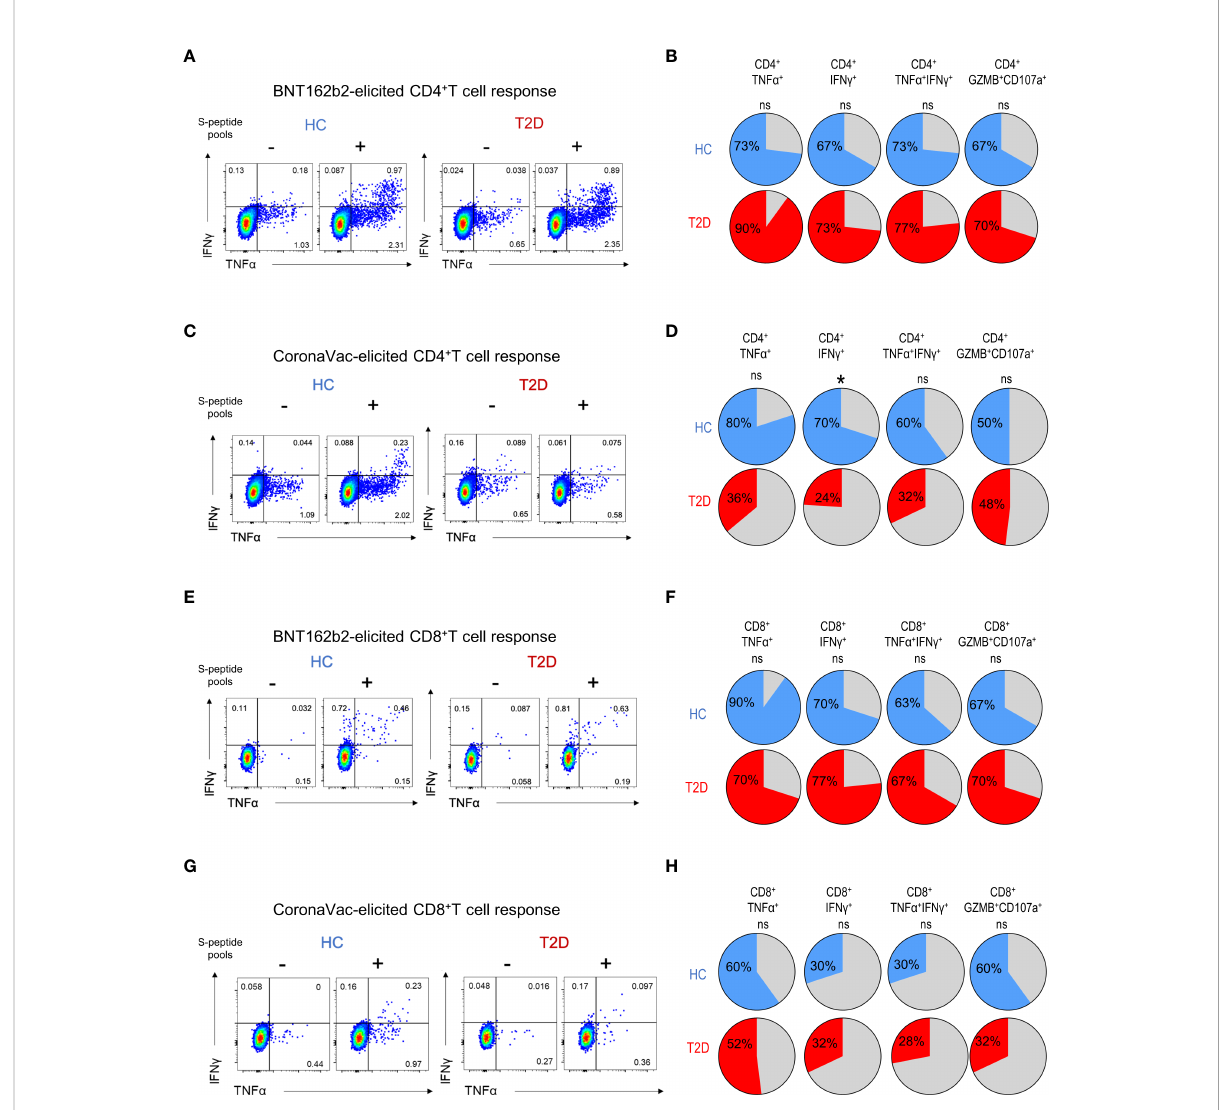
FIGURE 2 Proportions of participants harbouring memory T cell responses 3-6 months following BNT162b2 and CoronaVac vaccination. PBMCs collected from BNT162b2 (n=30/group) (A, B, E, F) and CoronaVac (n=10-25/group) (C, D, G, H) vaccinees were stimulated with S1 peptide pools. (A, D) Representative fl ow cytometry plots of cytokine-producing CD4 + T cells with or without peptide stimulation. (B, D) Proportions of HCs and type 2 diabetic patients with cytokine (TNF a + , IFN g + , TNF a + IFN g + and GZMB + CD107a + )-producing CD4 + T cells following peptide stimulation. (E, G) Representative fl ow cytometry plots of cytokine-producing CD8 + T cells with or without peptide stimulation. (F, H) Proportions of HCs and type 2 diabetic patients with cytokine (TNF a + , IFN g + , TNF a + IFN g + and GZMB + CD107a + )-producing CD8 + T cells following peptide stimulation. ns: not signi fi cant;